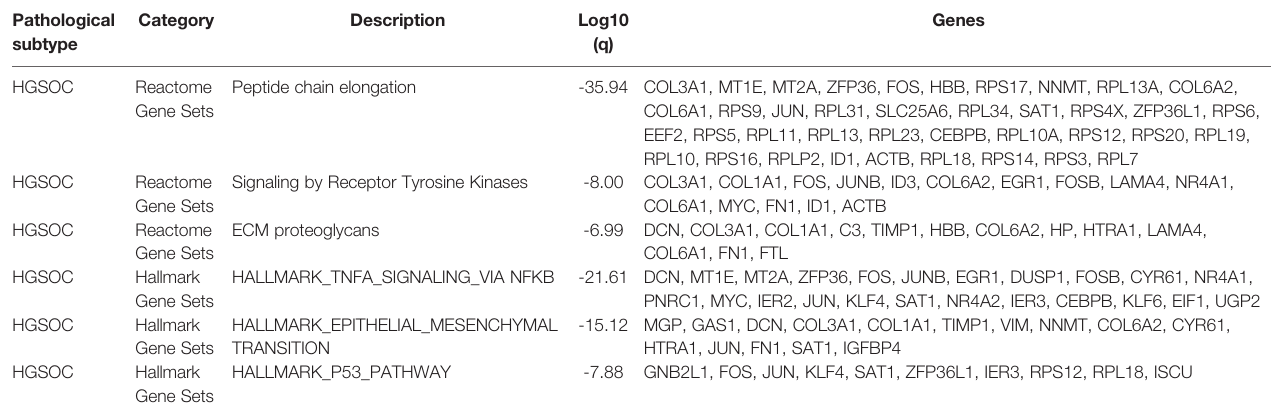
TABLE 1 | Functional enrichment analysis based on the upregulated genes in HGSOCs Scissor + cells versus All other cells (Scissor - and Background cells). Pathological